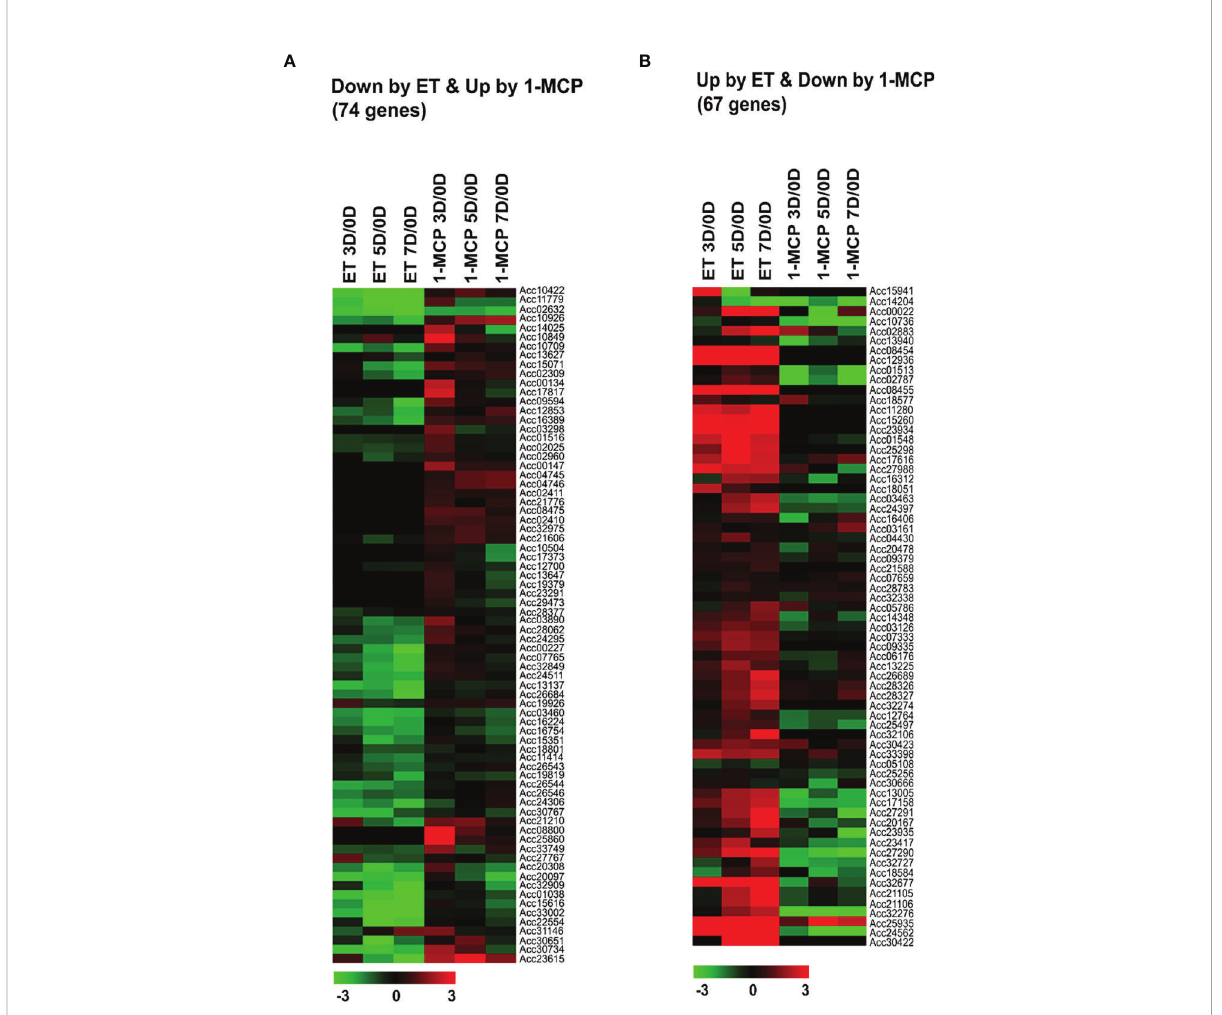
FIGURE 3 Normalized heatmaps showing expression levels of differentially expressed ‘ cell wall ’ -related genes inversely affected by ET and 1-MCP treatment along ripening time course. (A) Seventy-four cell-wall-related genes showed downregulated expression in ET treatment and upregulated expression in 1-MCP treatment. (B) Sixty-seven cell-wall-related genes showed upregulated expression in ET treatment and downregulated expression in 1-MCP treatment. Expression level of cell wall-related genes showing differential expression in treated samples stored for 3 vs. 0 days (3D/0D), 5 vs. 0 days (5D/0D), and 7 vs. 0 days (7D/0D). ET, ethylene; 1-MCP,